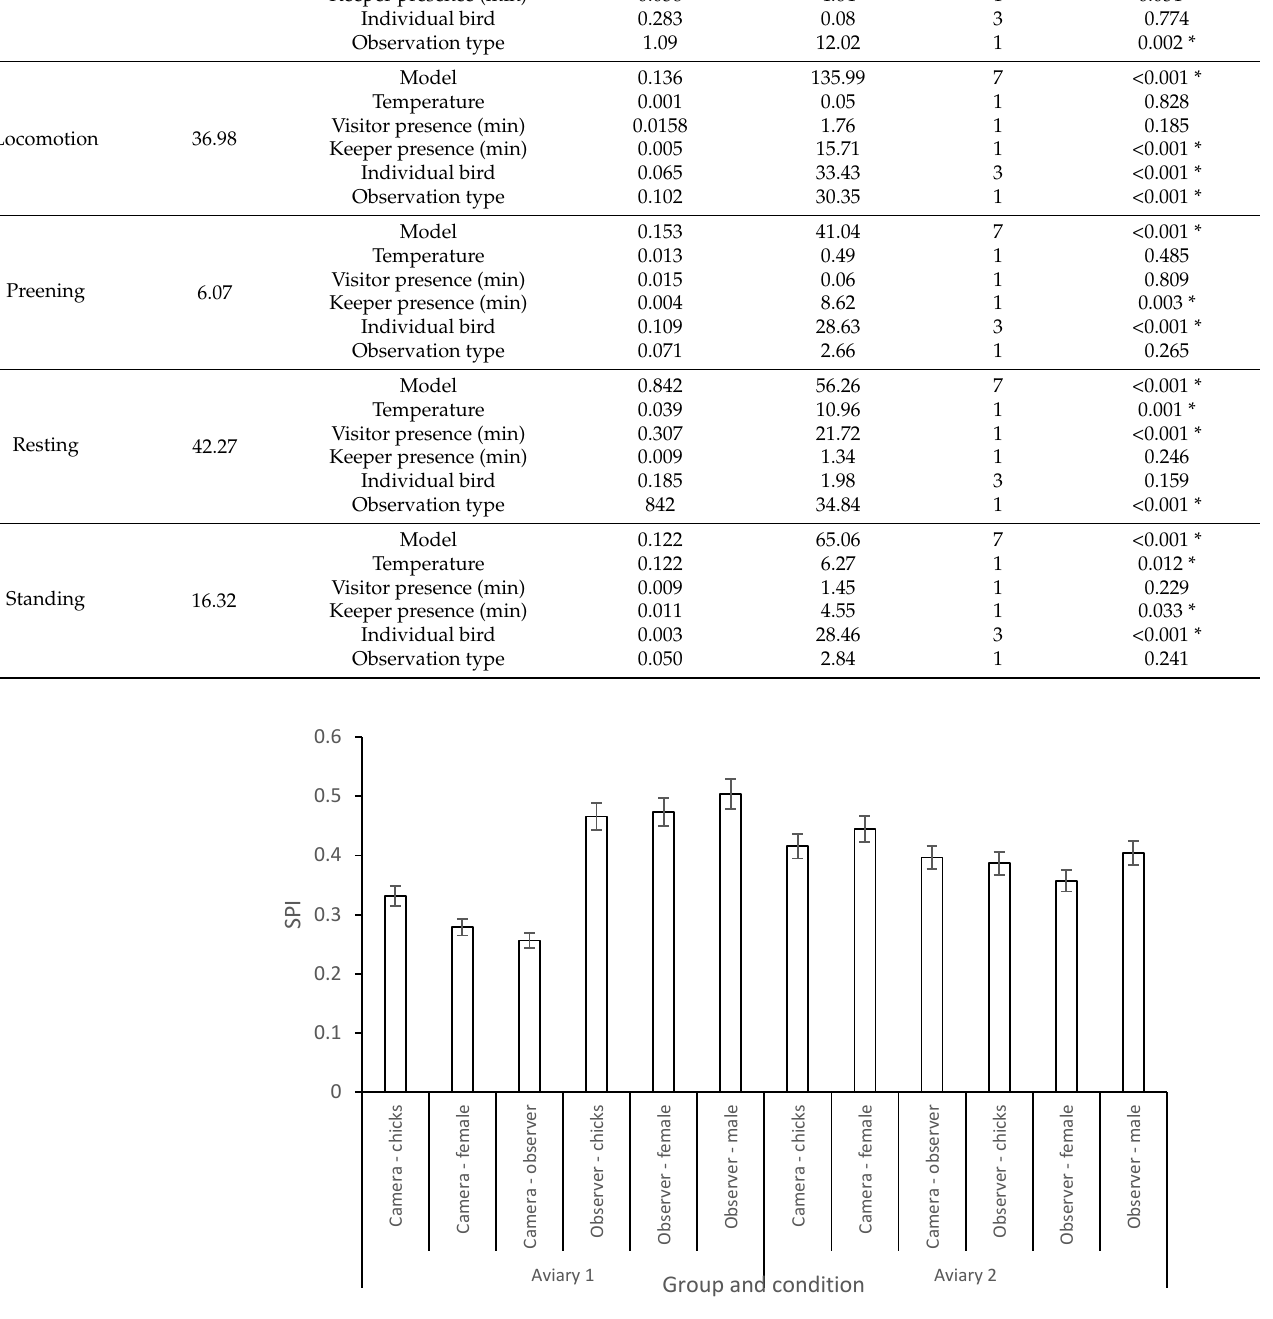
Figure 6. SPI values for birds in both aviaries (+/ − standard deviation), compared between observer and camera